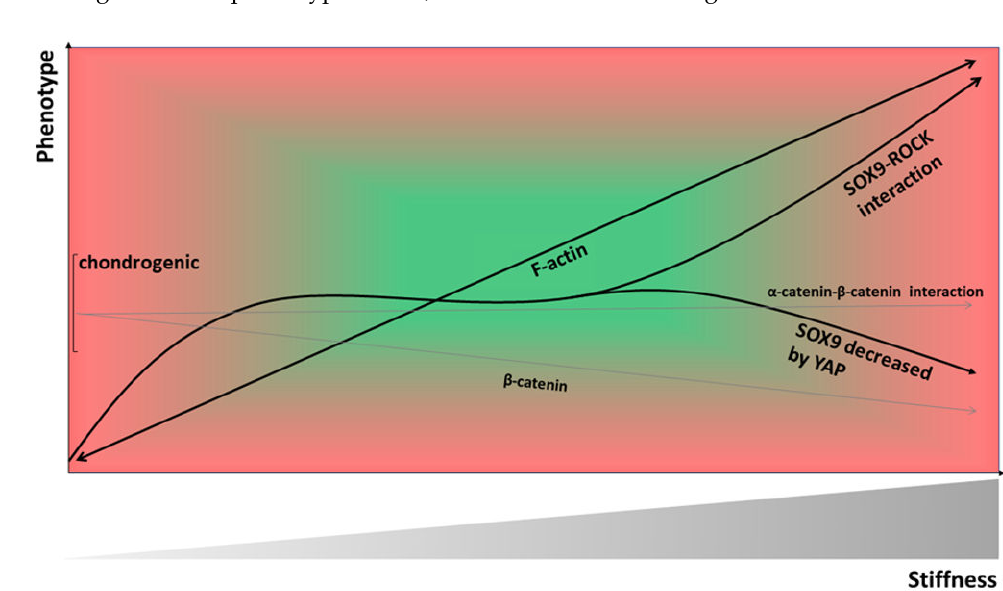
Figure 5. Model of the material sti ff ness-dependency of CH phenotype. The most prominent signaling pathway involved in sti ff ness sensing is the RhoA / ROCK pathway. For CHs, a direct ROCK–SOX9 interaction can explain the sti ff ness-mediated e ff ects on CH phenotype, as SOX9 is a potent chondrogenic transcription factor. With increasing sti ff ness RhoA / ROCK induces more actin polymerization and stress fiber formation, which has an inverse correlation with CH di ff erentiation in some studies and in others RhoA / ROCK signaling appears to act both pro- and anti-chondrogenically. We suggest resolving this apparent contradiction of the di ff erential e ff ects of RhoA / ROCK on CH phenotype by suggesting that the e ff ects of a direct ROCK–SOX9 interaction define the CH phenotype at sub-chondrogenic and chondrogenic sti ff nesses and that the stress fiber-inducing e ff ects of ROCK and subsequent induction of de-di ff erentiation define CH phenotype at supra-chondrogenic sti ff nesses. The YAP / TAZ pathway is also regulated by material-sti ff ness. High material sti ff ness acts through increased YAP expression and nuclear accumulation as a negative regulator of a healthy chondrogenic CH phenotype. As already and chondrogenic sti ff nesses, whereas not only the stress fiber-inducing e ff ects of ROCK, but also supra-chondrogenic sti ff nesses. This assumed association between YAP and SOX9 would require increasing levels of YAP expression and nuclear accumulation with decreasing levels of SOX9.